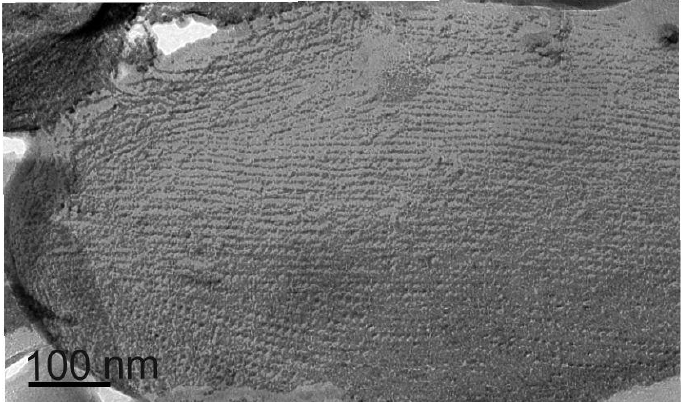
Figure 1. Freeze-etched and platinum-carbon shadowed preparation of a T. forsythia cell showing the square S-Layer lattice with a lattice spacing of approximately 10 nm × 10